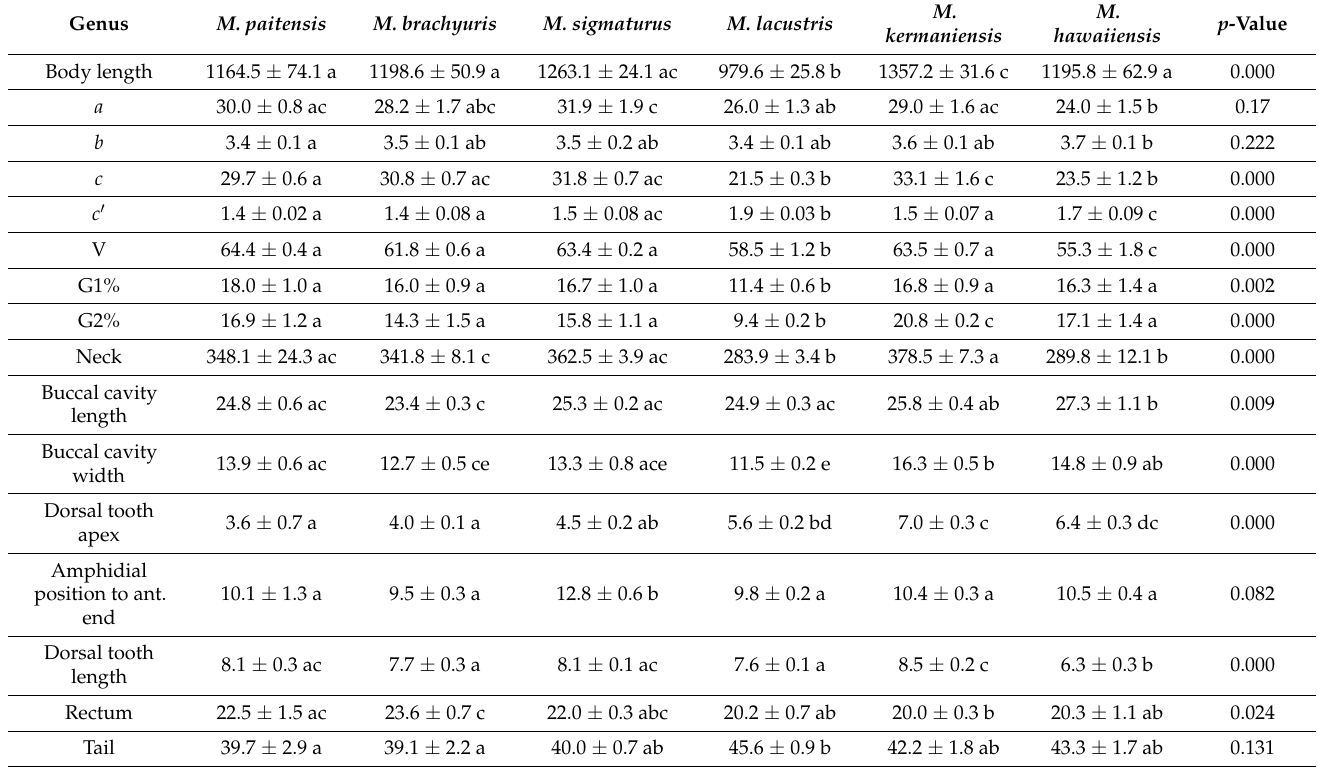
Table 4. Descriptive statistics of morphometrics for six Mylonchulus species from Iran (Mean ± Standard Error). Characters with similar letters have no significant